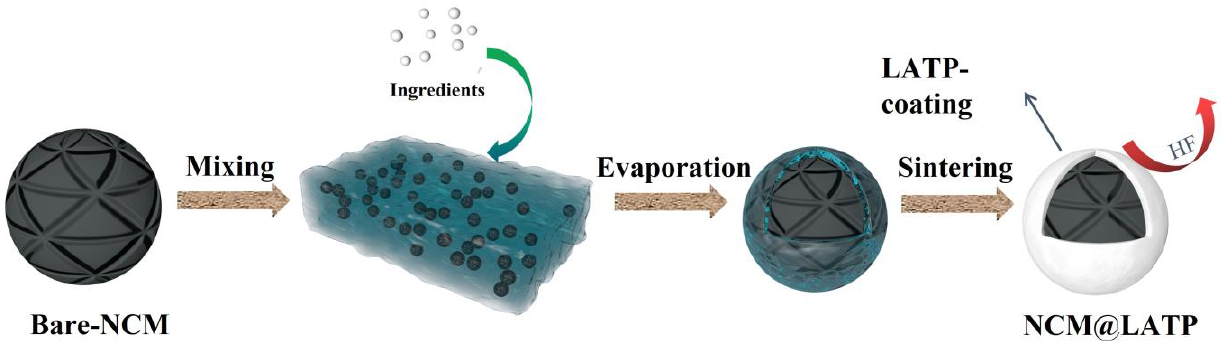
Figure 1. Schematic illustration for the LATP coating process.